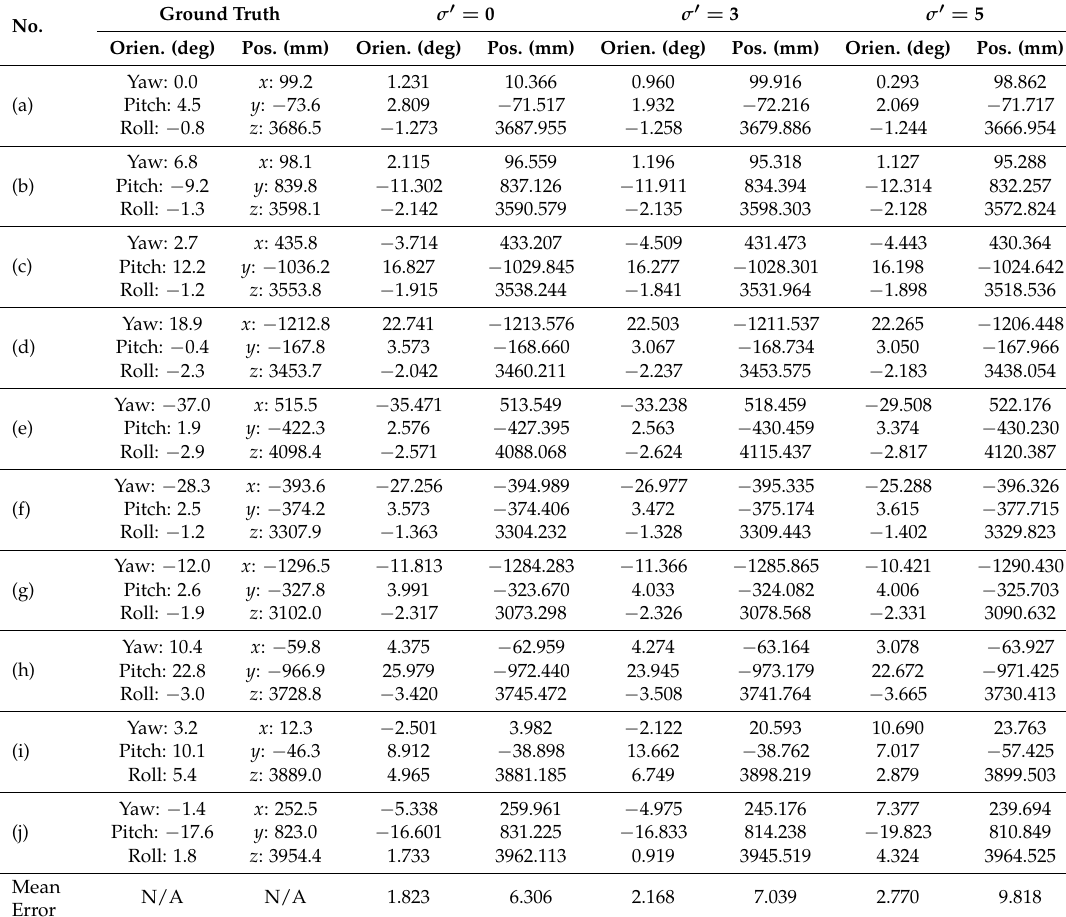
Table 3. Ground pose-estimation performance. Results in the table correspond to the figures given in Figure